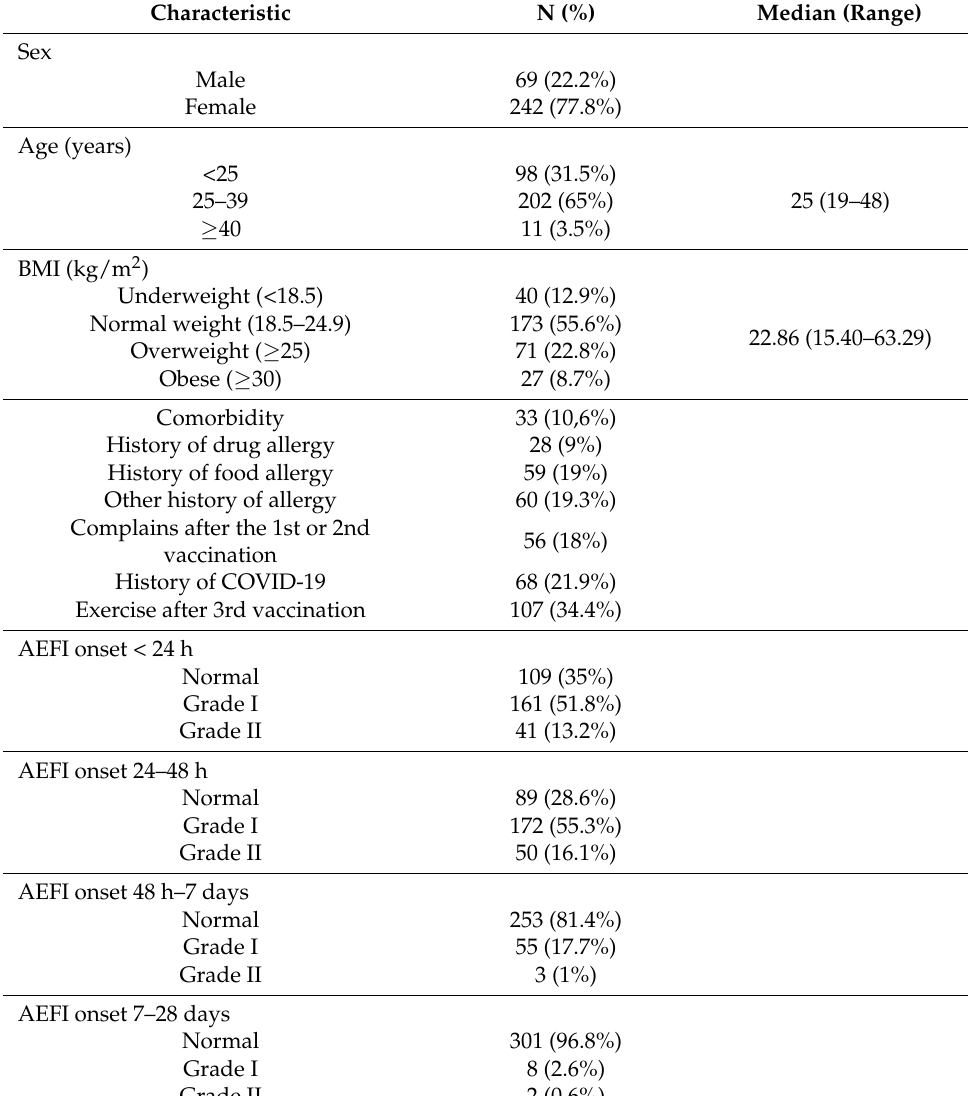
Table 1. Subject